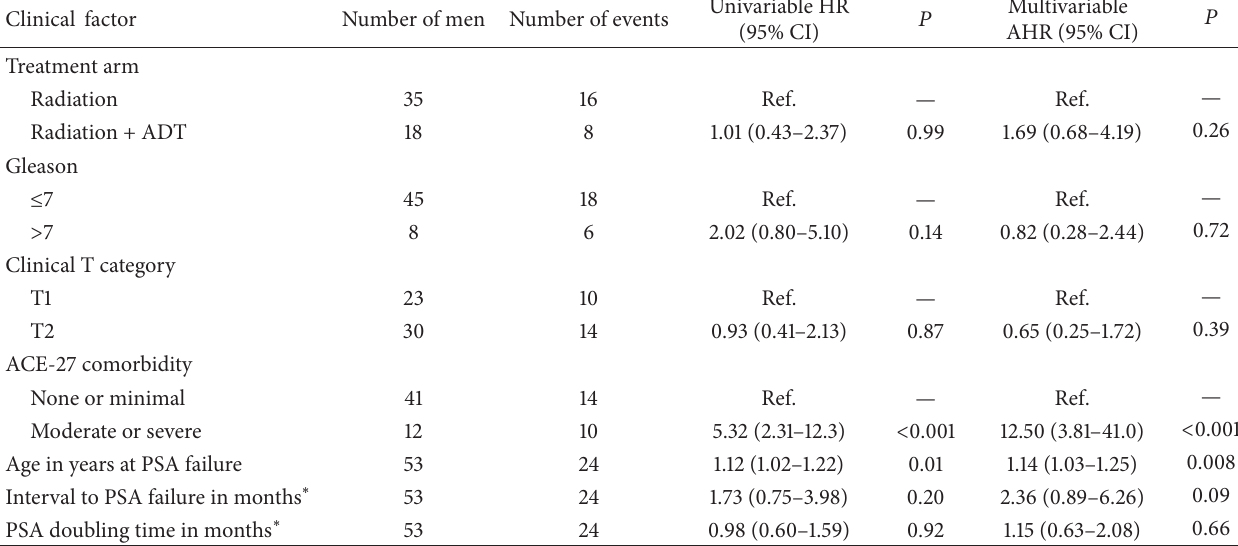
Table 2: Unadjusted and adjusted hazard ratios for all-cause mortality following PSA failure.